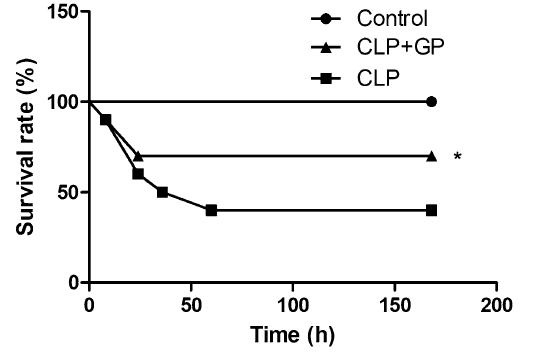
Figure 2. Effects of propolis on survival. * p < 0.05 versus CLP.